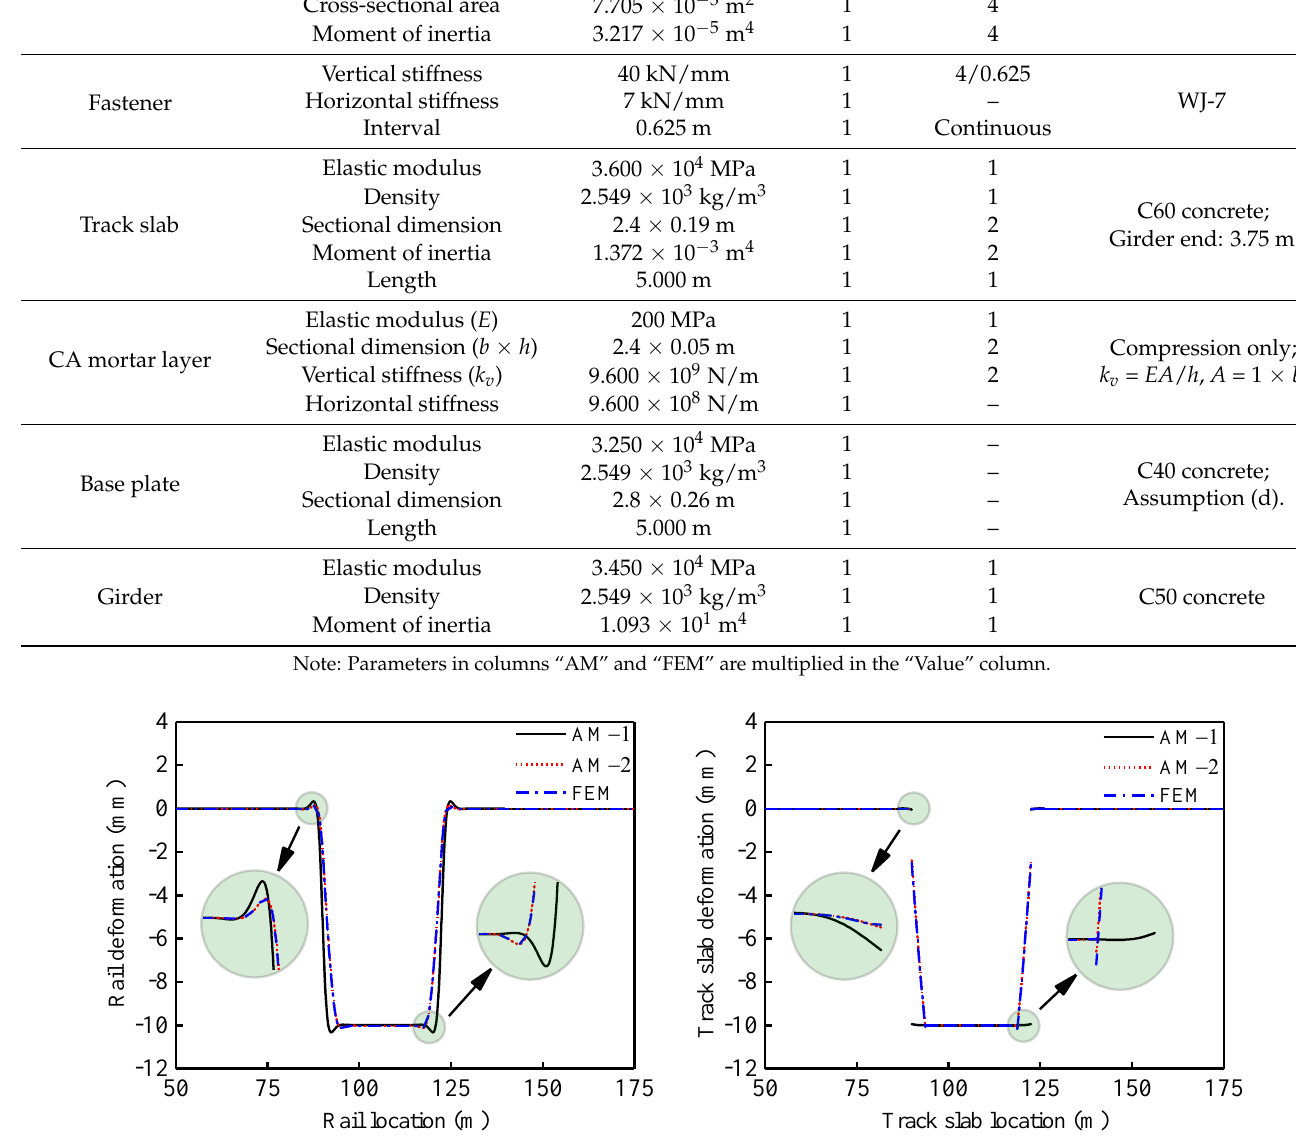
( b ) Figure 5. Case 2 ( a ) rail deformation; ( b ) track slab deformation.